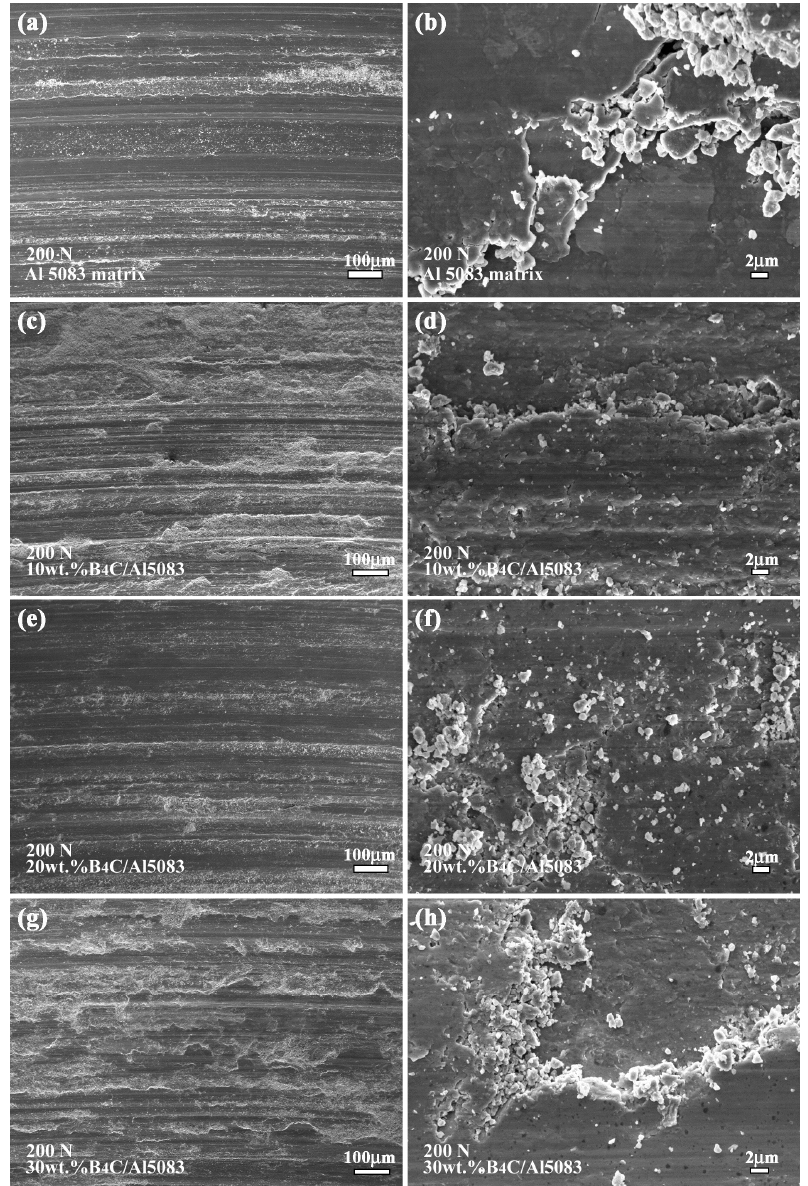
Figure 8. Worn surface of ( a ) Al 5083 matrix at 200 N; ( b ) magnified morphology of ( a ); ( c ) 10 wt % B 4 C/Al 5083 composite at 200 N; ( d ) magnified morphology of ( c ); ( e ) 20 wt % B 4 C/Al 5083 composite at 200 N; ( f ) magnified morphology of ( e ); ( g ) 30 wt % B 4 C/Al 5083 composite at 200 N and ( h ) magnified morphology of ( g ).